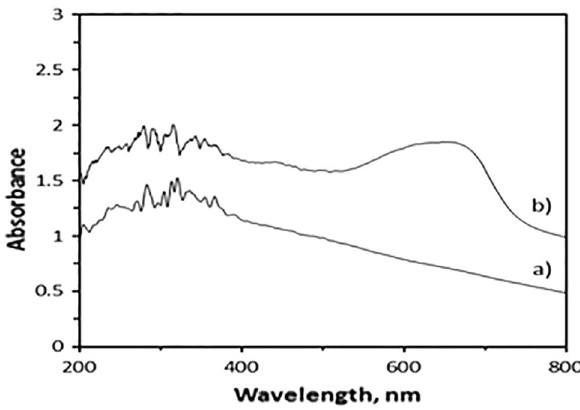
Fig. 10 UV–Vis spectra of the sorbent a before and b after